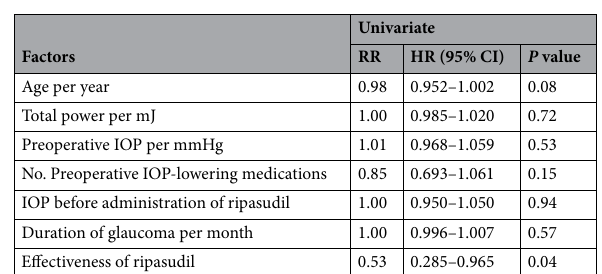
Figure 3. Kaplan–Meier survival curve of surgical outcomes in the ripasudil effective vs. non-effective eyes. ( A ) Need for a subsequent glaucoma procedure, including repeat SLT. ( B ) An increase from baseline in the number of IOP-lowering medications. ( C ) Change of the IOP on any two consecutive visits: IOP > 21 mmHg or IOP reduction < 20% from baseline. There were no significant differences noted between the groups for any of the criteria.